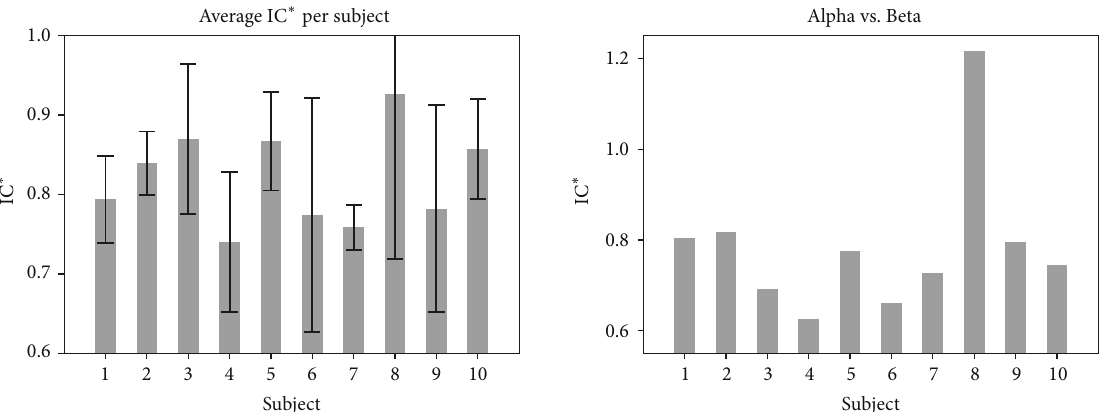
Figure 6: (Left) average and standard deviation of the 𝐼𝐶 ∗ values for all pairwise comparisons of the four (theta, alpha, beta, and gamma) networks, as a function of the considered individual. (Right) 𝐼𝐶 ∗ resulting of comparing the networks for the alpha and beta frequency bands, for all ten individuals.